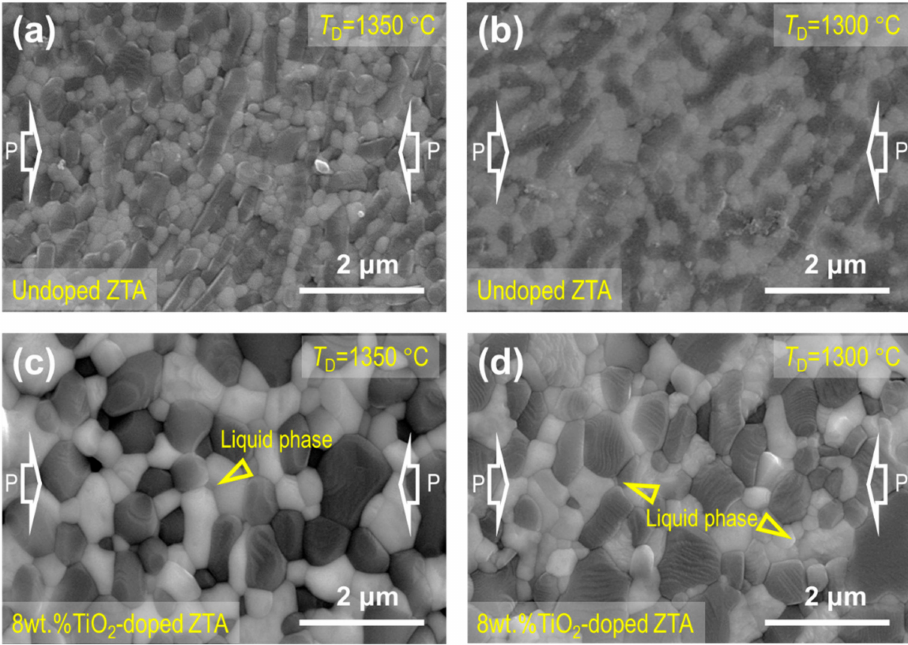
Figure 3. Microstructures of the ( a – b ) undoped and ( c – d ) 8 wt.%TiO 2 -doped ceramics after deformation. The compression stress axis is marked by the white hollow